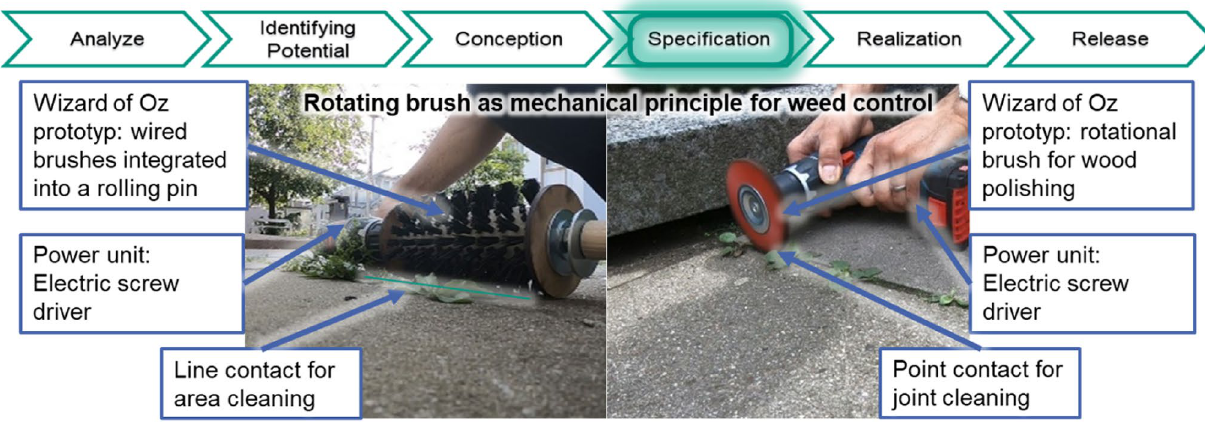
Fig. 10 Example prototypes for mechanical brush weed